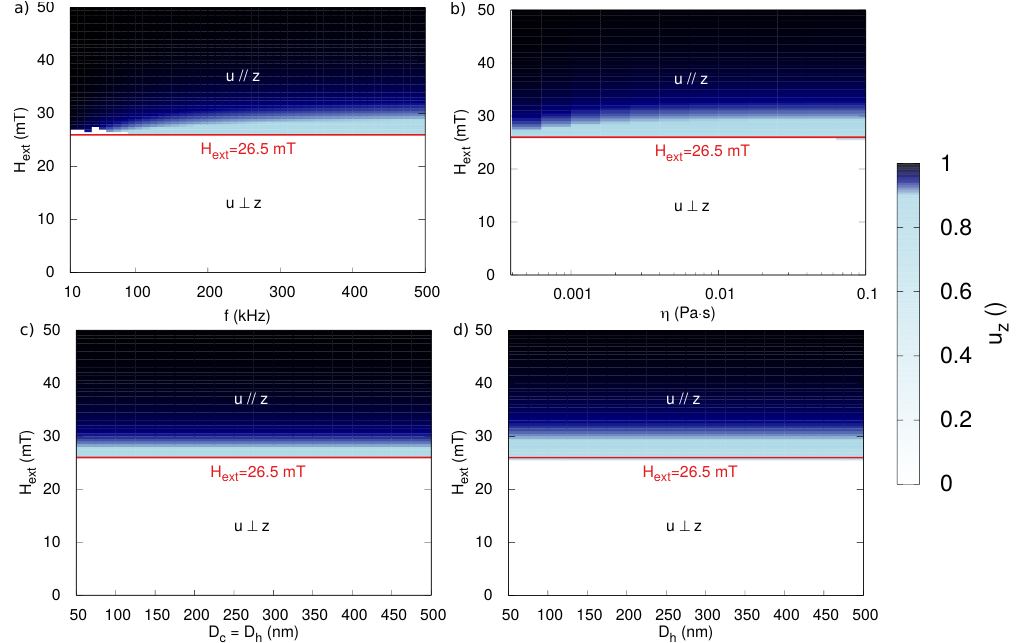
Figure 3. The z-component of the anisotropy, averaged over one period, in dynamical equilibrium during the application of the sinusoidal time-varying field. Panels ( a , b ) show u z as function of H ext for different applied frequencies and viscosities, respectively. Panels ( c , d ) show the independence on the size of both the core D c and hydrodynamic D h diameter, both for D c = D h (panel ( c )) or for varying D h at fixed D c = 150 nm (panel ( d